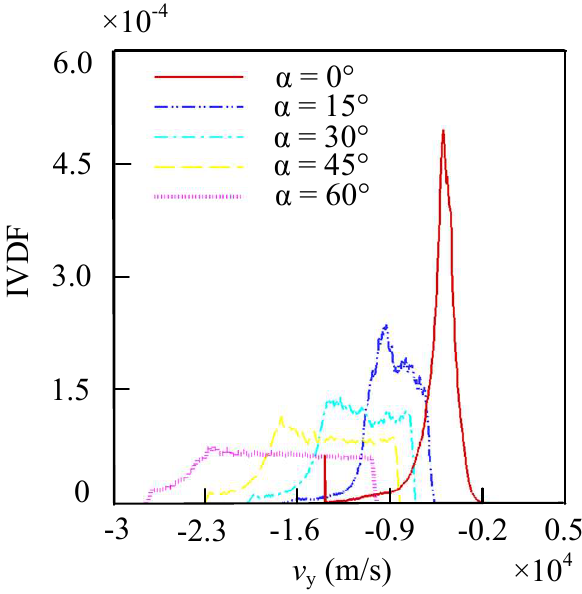
Figure 9. Ion velocity distribution function for radial component with different values of the positive α.